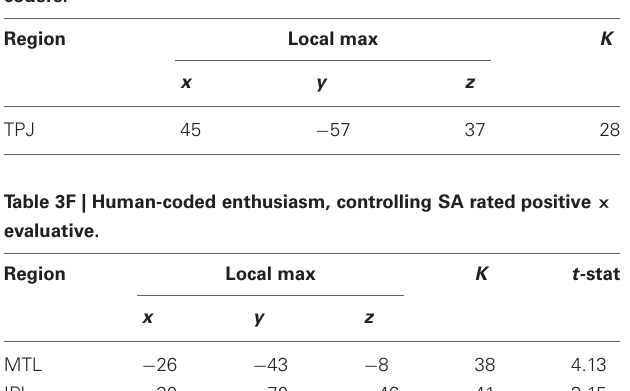
Table 3E | Conjunction analysis of (b) positive correlations with positive × evaluative, as rated by the automated sentiment analyzer and (c) positive correlations with enthusiasm, as rated by human coders.